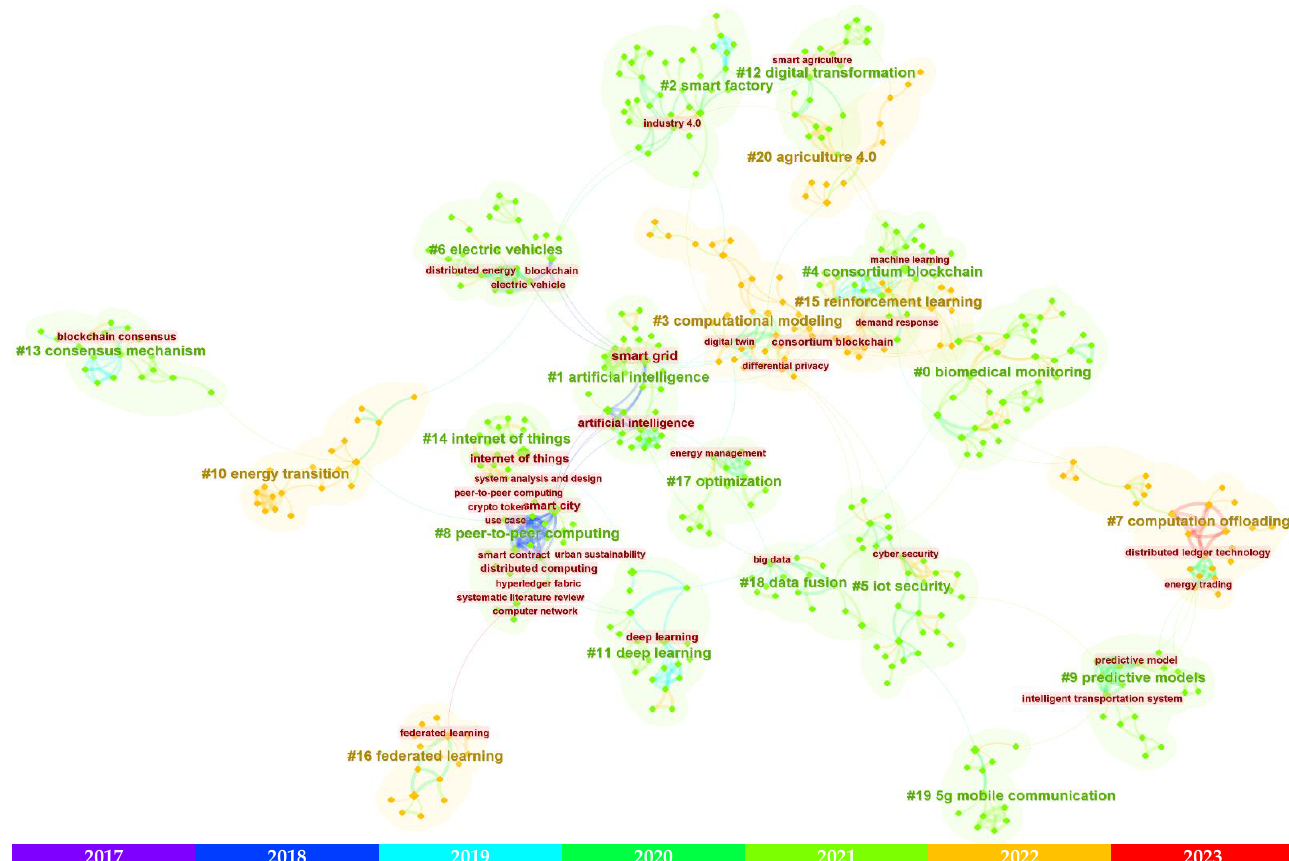
Figure 9. Largest keywords’ co-occurrence clusters in the subject field.